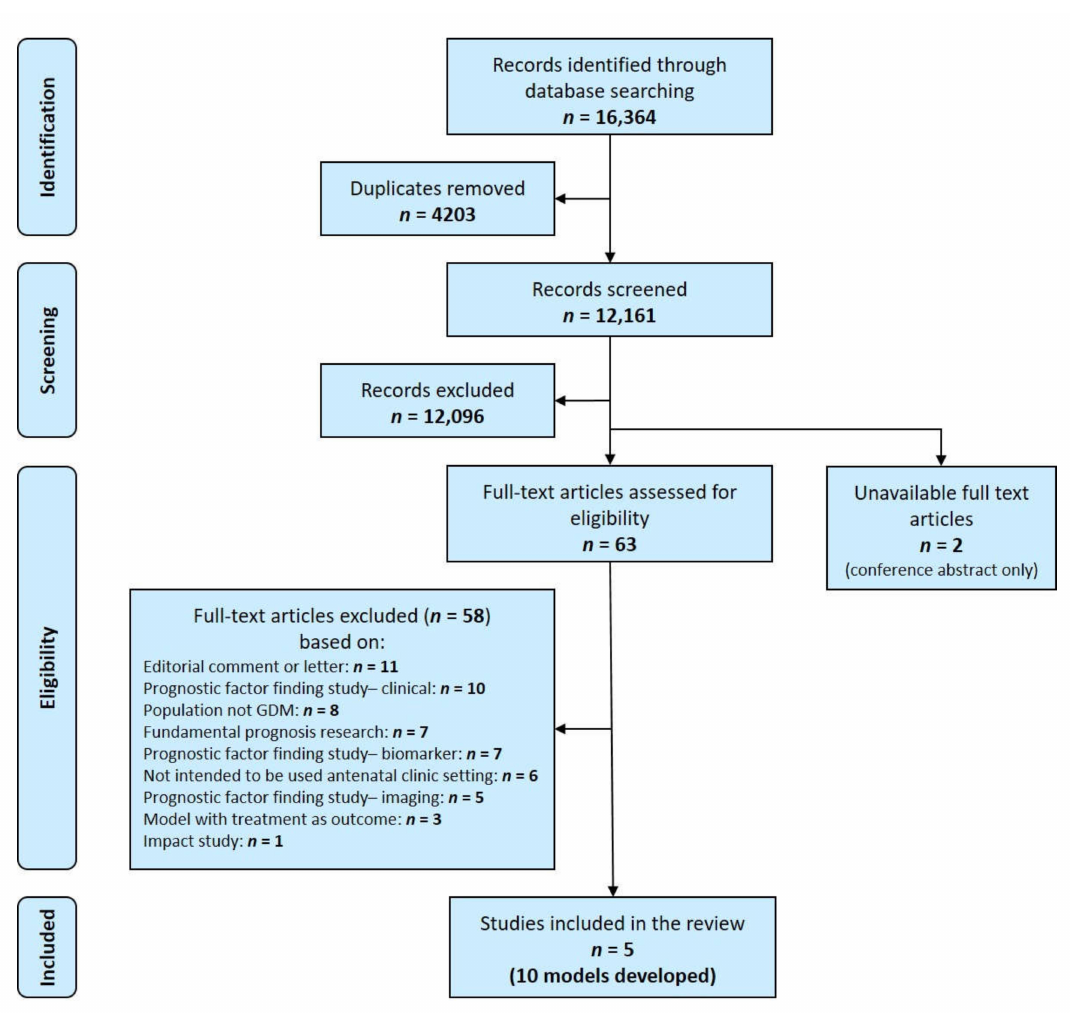
Figure 1. Flow diagram of the identification, screening and eligibility assessment of the literature for prediction models for pregnancy complications in women with gestational